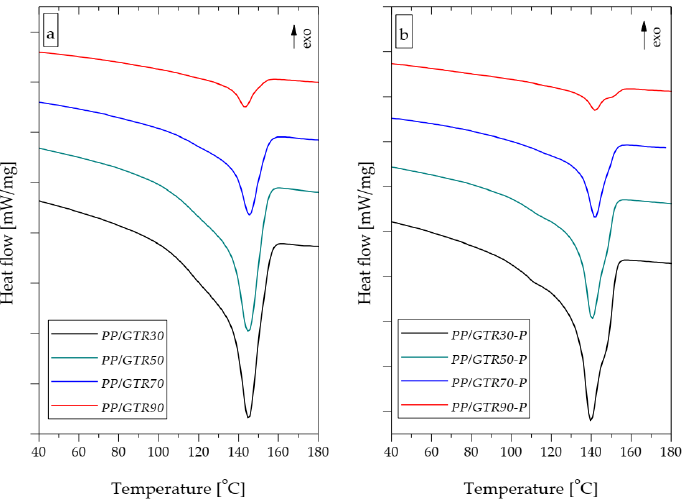
Figure 12. DSC melting curves of PP/GTR ( a ) and PP/GTR-P ( b ) compounds .